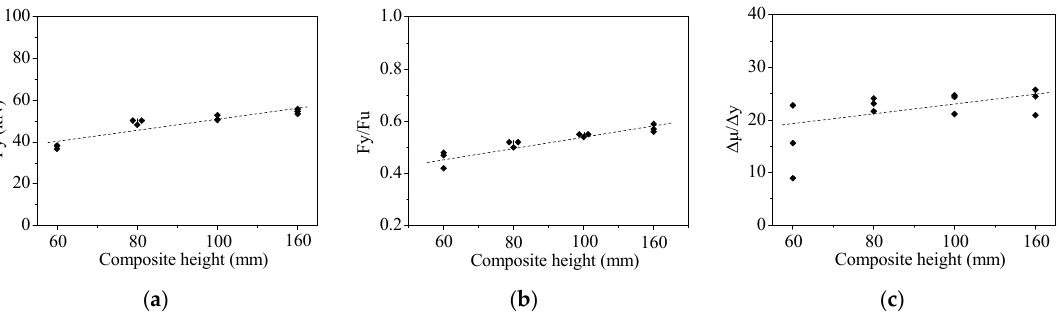
Figure 7. Results analysis of composite height tests. ( a ) Yield strength analysis; ( b ) Yield ratio analysis; ( c ) Ductility analysis.